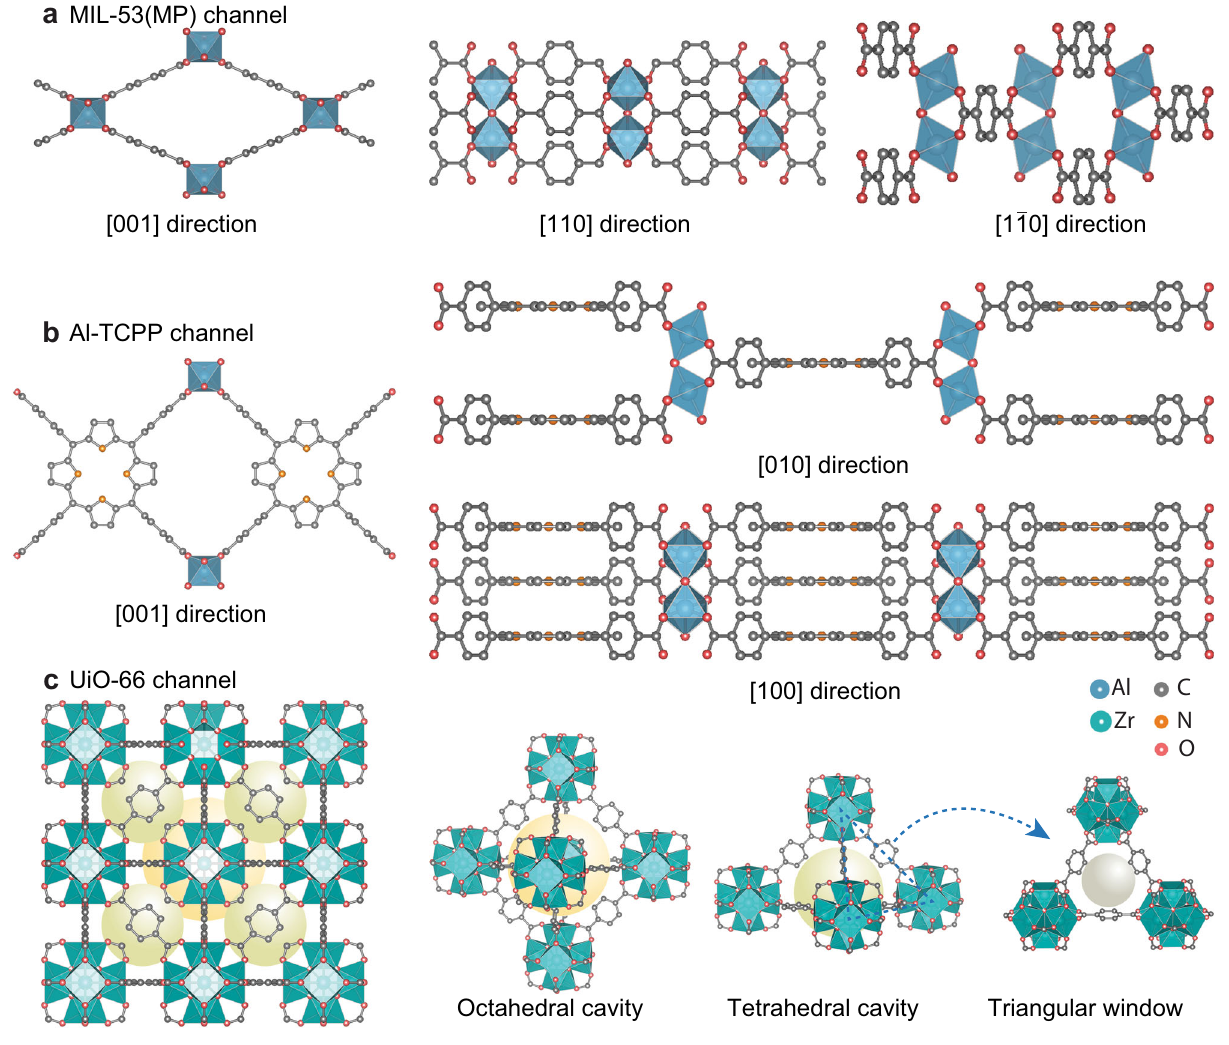
Fig. 1 | Schematics ofMOF channelstructures withvariouscon fi gurations(top views). a MIL-53(MP) channel with medium pore form along the [001] direction, [110] direction, and [110] direction, respectively. The 1D channel is in the [001] direction. b Al-TCPP channel along the [001] direction, [010] direction, and [100] direction, respectively. The 1D channel is in the [001] direction, and the 2D